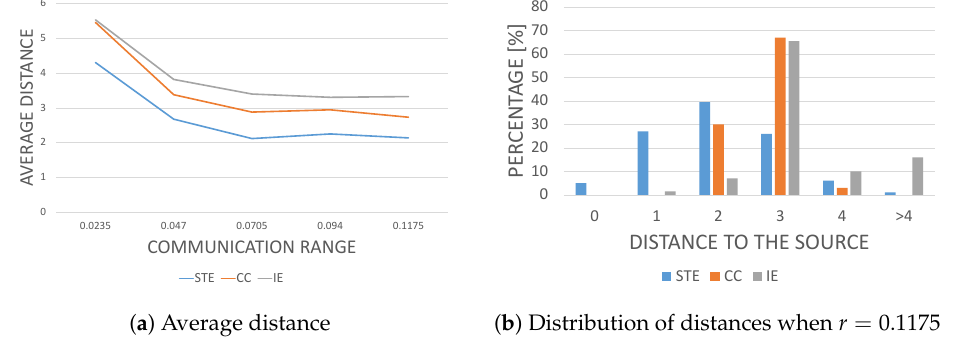
Figure 6. Performance of STE, CC, and IE in r -disk networks.